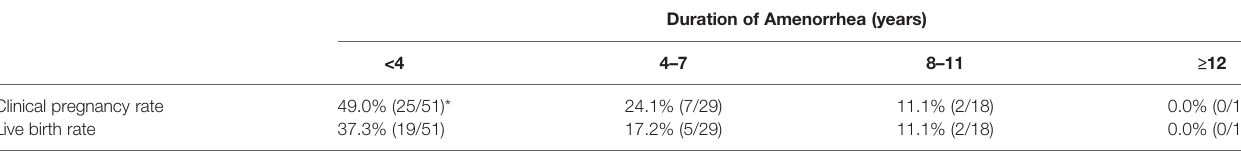
GroupIVF-1-a,patientswithoutpossibleiatrogeniccausesorchromosomalabnormalitiesinwhomovarianstimulationandIVF-ETwereattemptedabnormalityandwere<35yearsofage at the initiation of